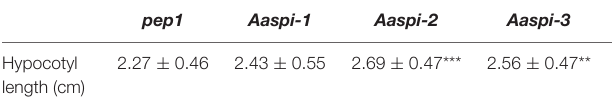
FIGURE 2 | The Aaspi distorted phenotype of trichomes, roots and epidermal pavement cells. First row: Microscopic pictures of distorted trichomes. Second row, left: Ratio of straight and curled trichomes in pep1 and Aaspi mutants. Second row, right: Number of trichome branches in pep1 and Aaspi mutants. Graph shows the relative abundance in% in more than 100 trichomes per line. Third row: Microscopic images of root hair phenotypes to illustrate the shorter root hairs in the Aaspi mutants. Scale bare: 300 µ m. Bottom row: Microscopic images of epidermal pavement cells to illustrate the lower complexity of epidermal pavement cells on cotyledons. Scale bar: 50 µ m.